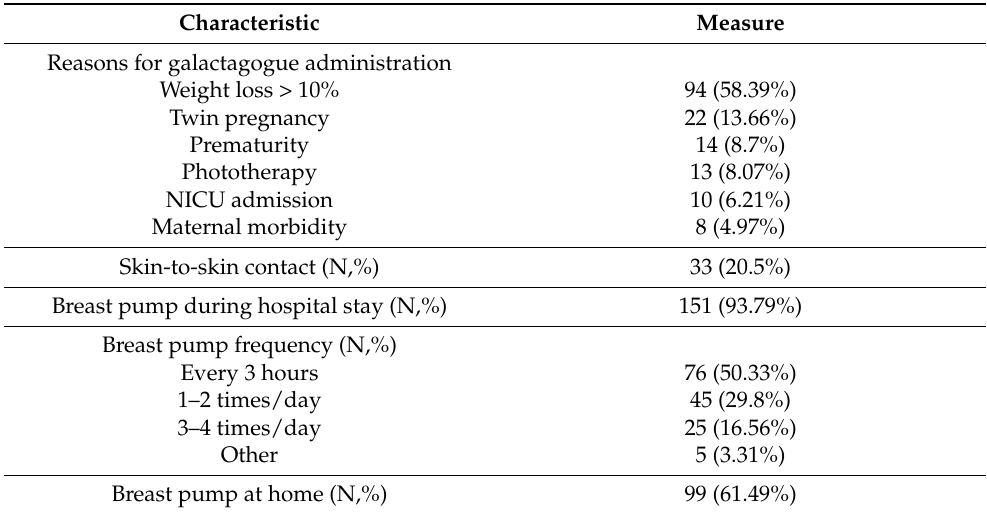
Table 3. Feeding characteristics in relation to the